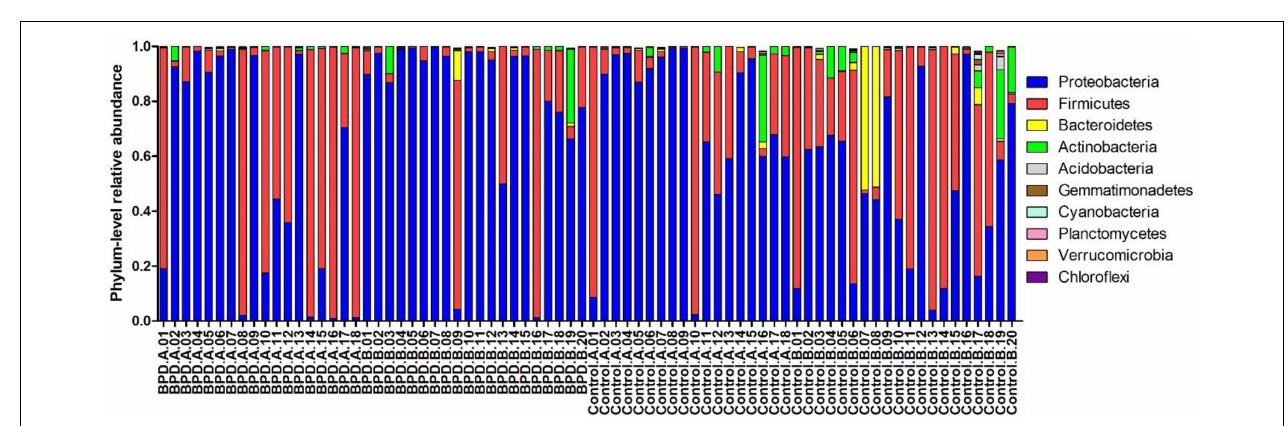
FIGURE 2 | The mean relative abundances of major microbiome (Top 10) of both groups at the genus level.